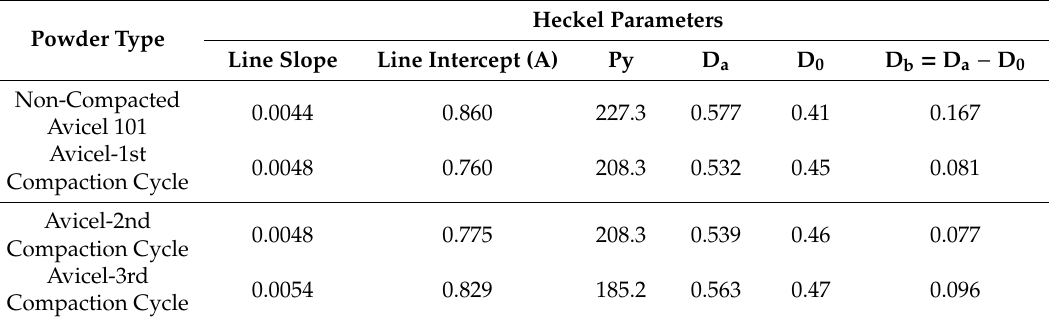
Table 3. Parameters derived from the Heckel plots of non-compacted and compacted Avicel ®® PH-101.